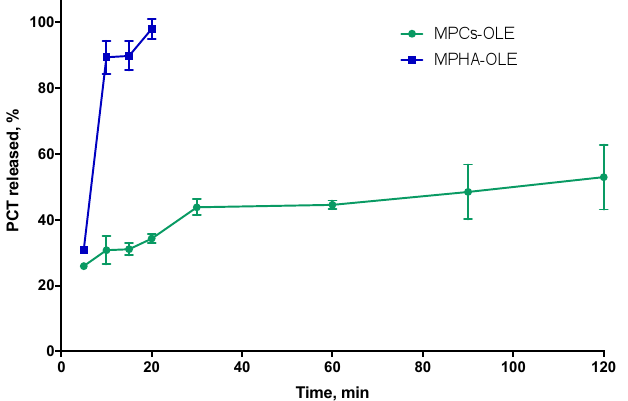
Figure 6. OLE release curves from MPHA-OLE or MPCs-OLE in pseudo extracellular fluid (PECF) at 37 °C. Means ± SD ( n = 3).